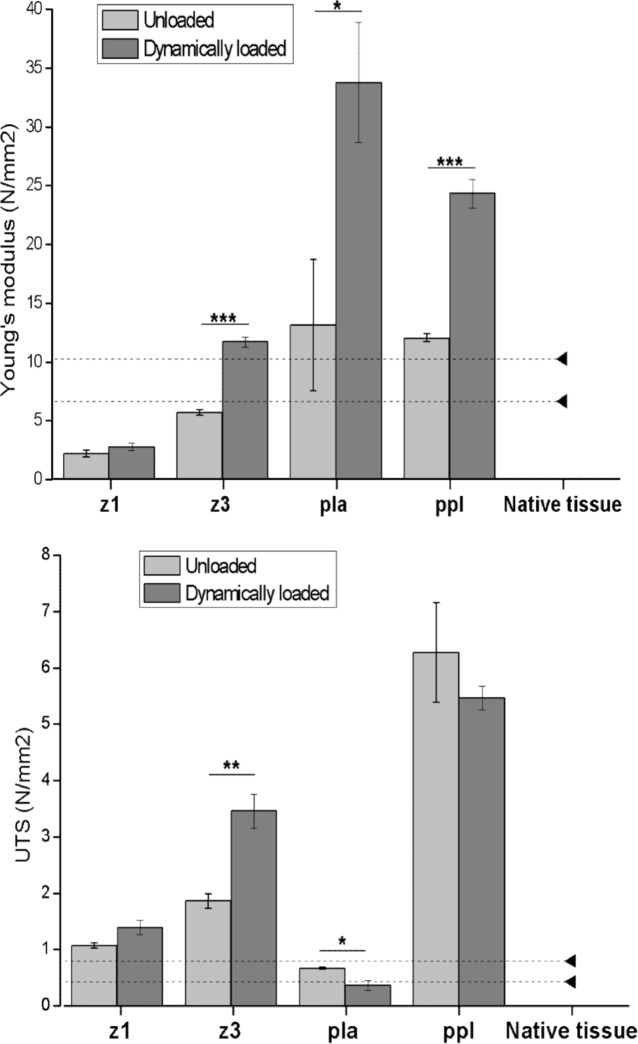
Values for Mechanical properties before and after 7 days of dynamic loading.Young’s Modulus (top) and ultimate tensile strength (bottom) calculated from stress curves before and after 7 days of uniaxial distension (n-2±SEM), *p<0.05, **p<0.01, ***p<0.001. Dotted lines represent values of healthy paravaginal tissues [24].